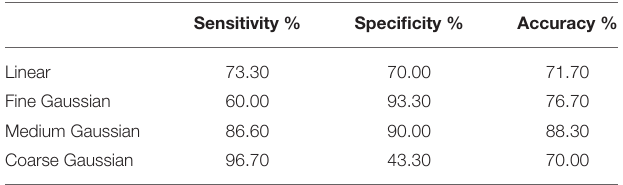
TABLE 4 | The SVM performance compare with different kernel for the proposed method.